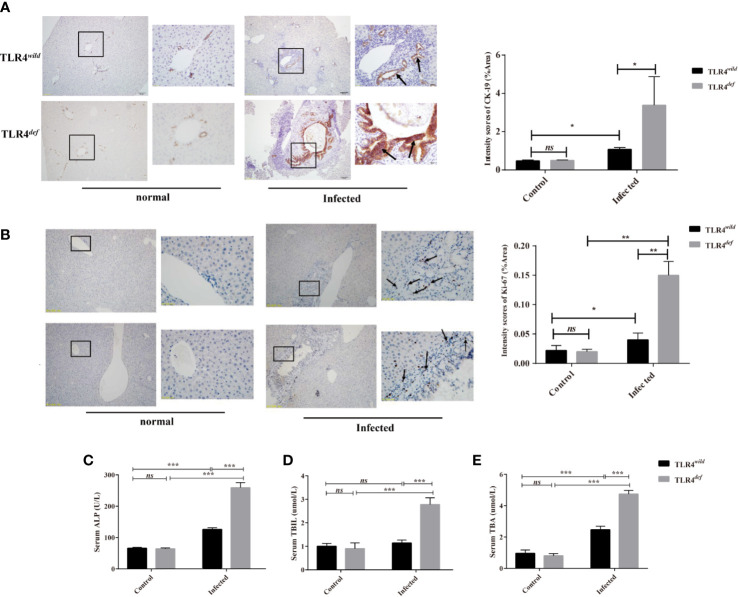
TLR4def promoted bile duct hyperplasia and biliary injuries in a resistant mouse strain of Clonorchis sinensis infection. (A, B) Hyperplasia of intrahepatic bile duct epithelial cells in mice with C. sinensis was indicated by immunohistochemical staining of CK19 (A) and ki67 (B), an arrow indicates the positive cells. (C–E) The activities of ALP (C), TBIL (D), and TBA (E) in the sera of TLR4wild and TLR4def mice were assessed for biliary injuries. The values were expressed as mean ± SEM. Compared with indicated groups, *P < 0.05, **P < 0.01, ***P < 0.001.